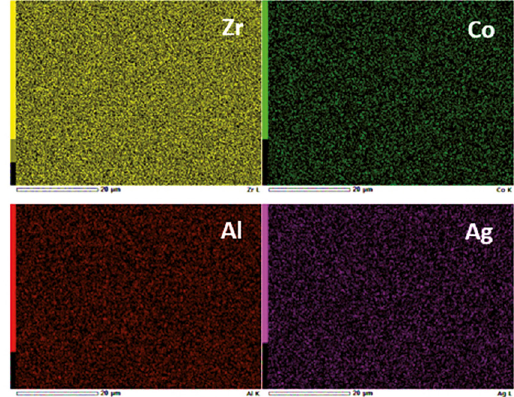
Co Al Ag BMG in 2 mm 57.52 21.24 9.24 12